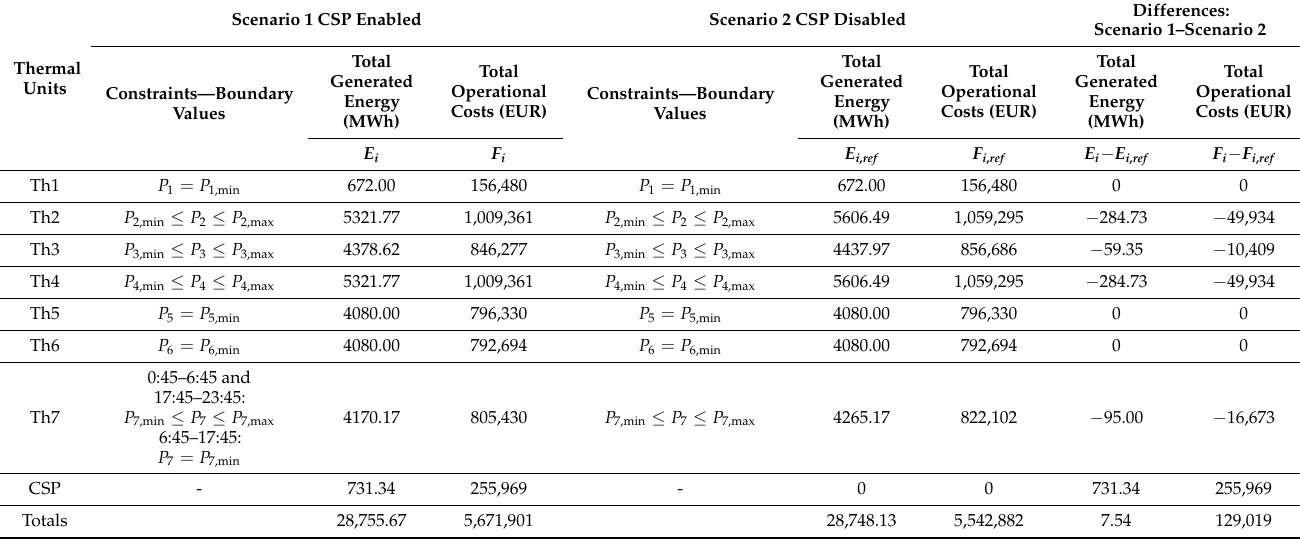
Table 1. Total Generated Energy and Total Operational Costs over 24 h.